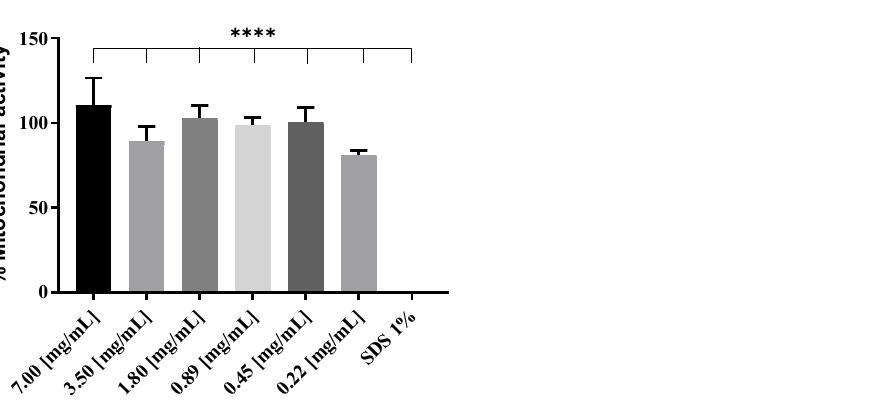
Figure 2. Effect on mitochondrial activity of different concentrations of blank DOTAP 4 liposomes on RAW 264.7 cells after 4 h incubation. Data were normalized to non-treated cell results; SDS served as positive control. Data are presented as mean ± SD ( n = 3). **** indicate p < 0.0001 when comparing SDS 1% group with other groups.